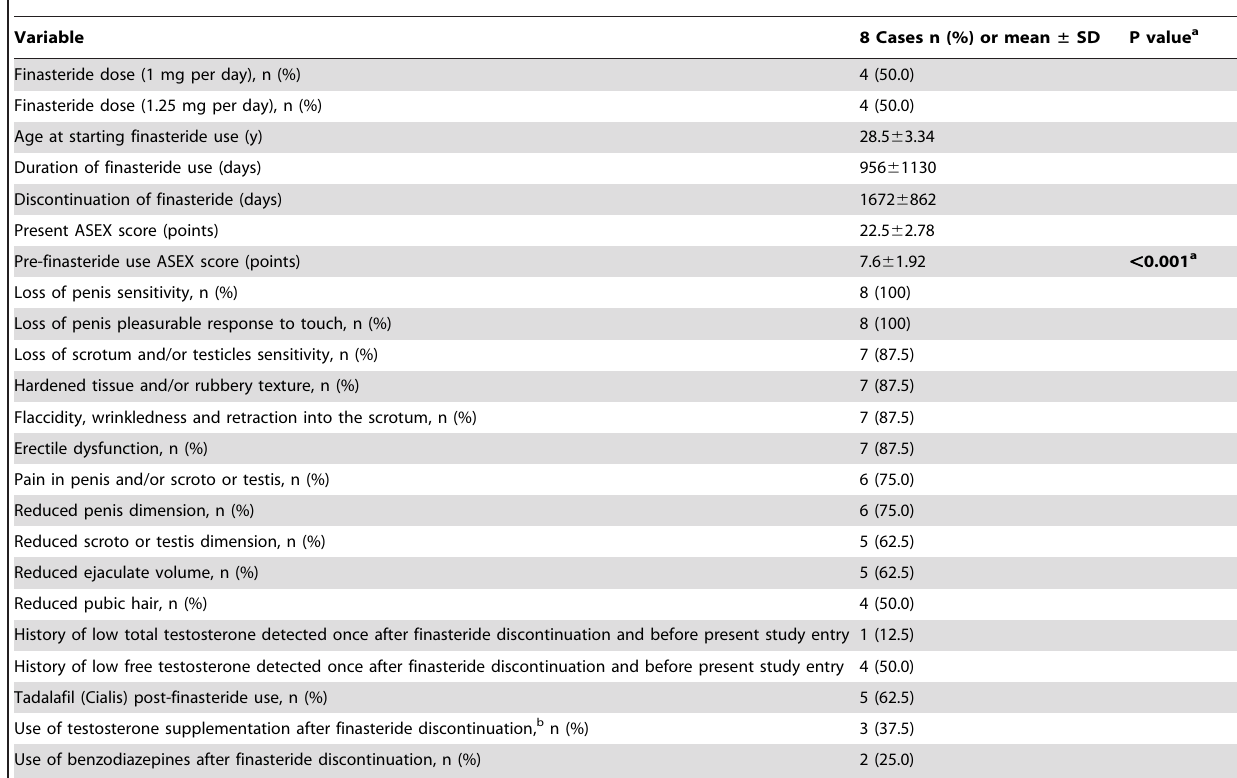
Table 1. Characteristics of 8 patients former finasteride users, finasteride self-reported side effects and sexual function